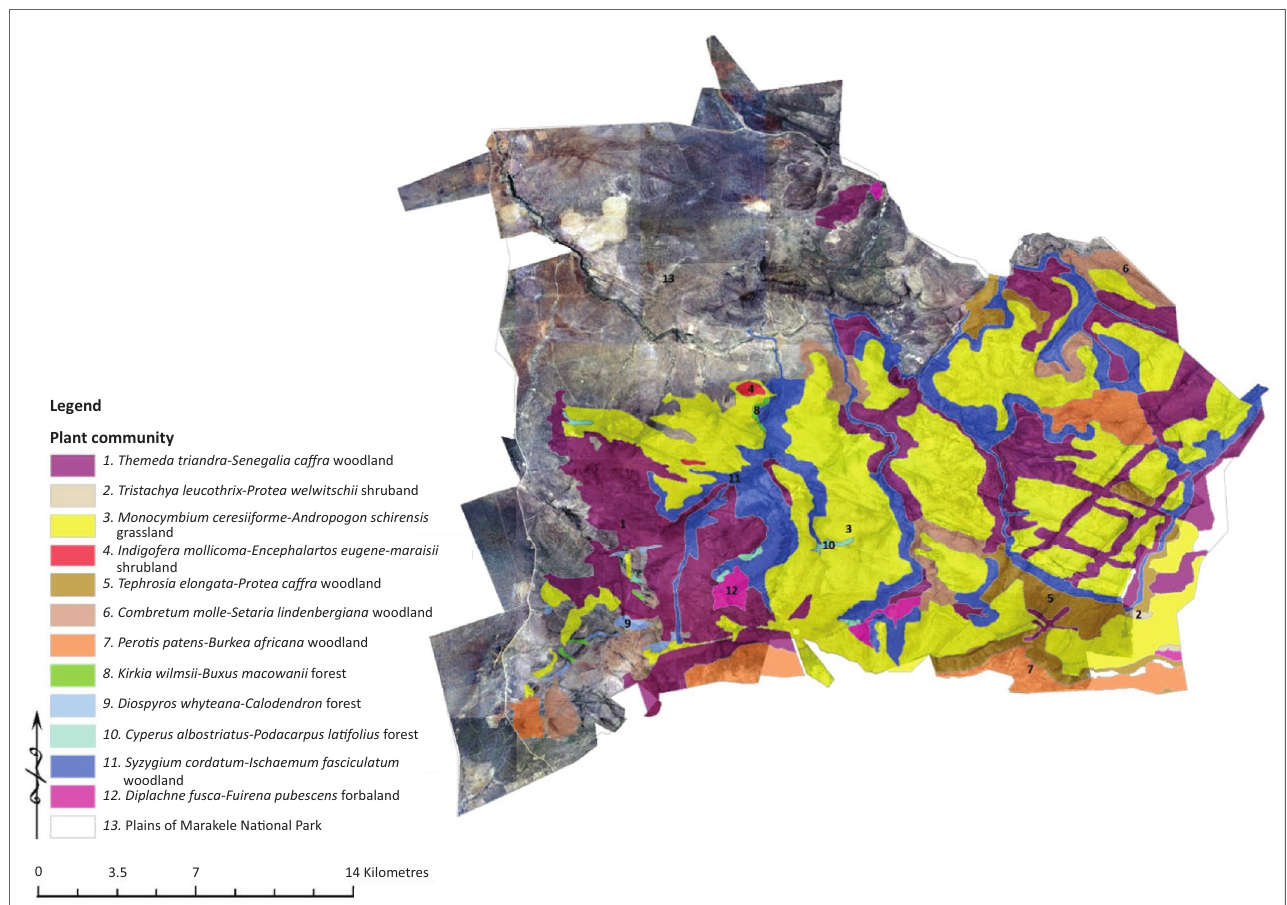
FIGURE 2: Plant communities of the mountainous vegetation of Marakele National Park.